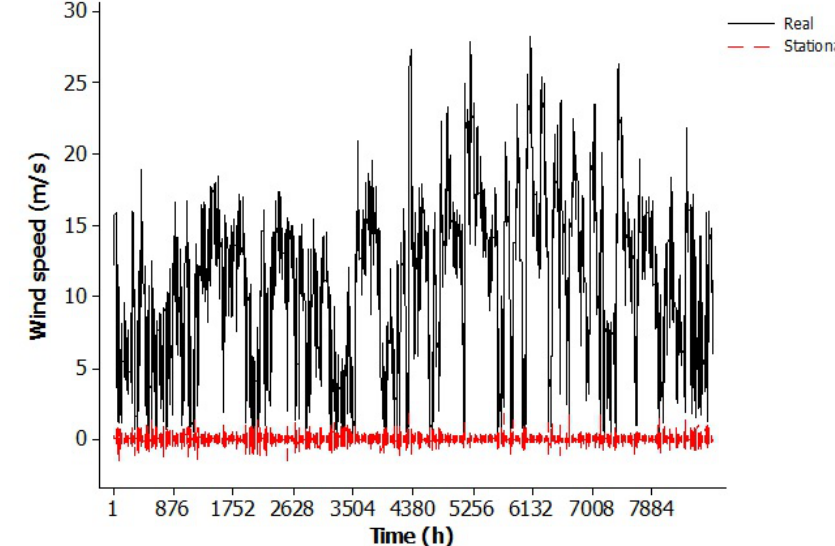
Figure 7. Real and stationary series from La Mata.